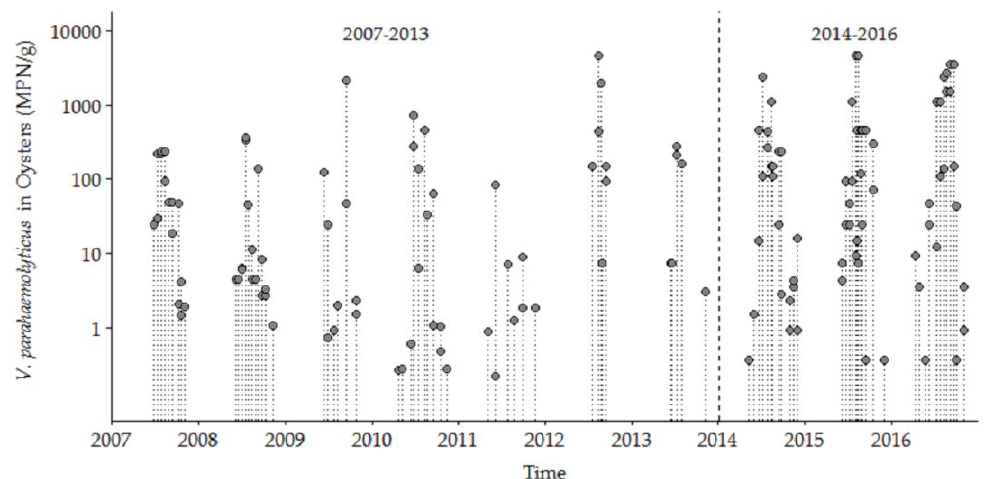
Figure 2. Vibrio parahaemolyticus concentrations in oysters from NI and OR at low tide in the Great Bay Estuary (GBE) in 2007 – 2016.